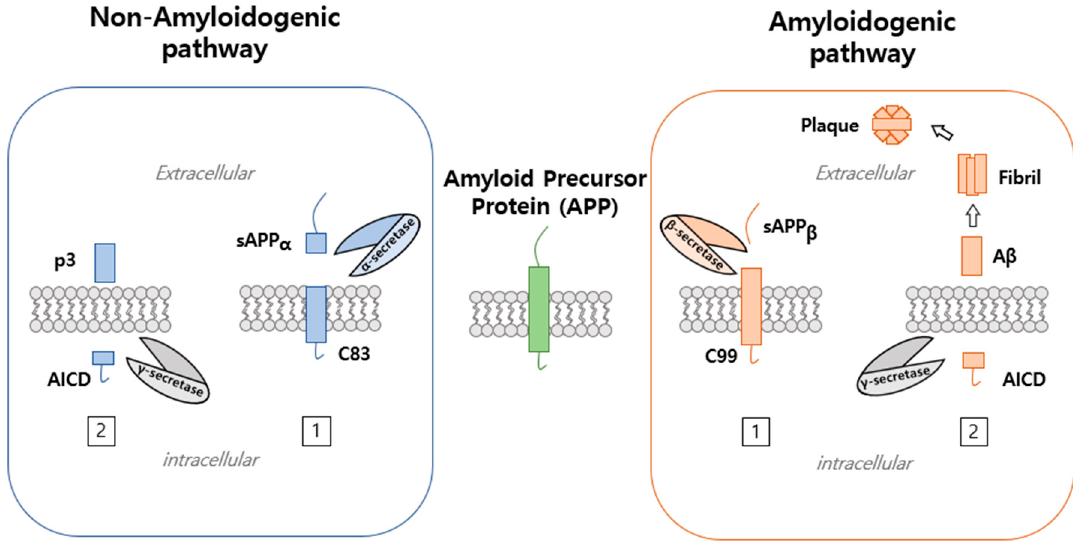
Figure 2. Processing pathway of amyloid precursor protein. APP processing is performed via the non-amyloidogenic or amyloidogenic pathways. The non-amyloidogenic pathway involves APP cleavage by α -secretase and generates soluble amyloid precursor protein cleaved by α -secretase (sAPP α ) and a C-terminal fragment of 83 (C83). This is followed by γ -secretase cleavage, which results in APP non-amyloidogenic extracellular fragment (p3) and APP intracellular domain (AICD). On the other hand, the amyloidogenic pathway involves APP cleaved by β -secretase to generate soluble amyloid precursor protein, which is further cleaved by β -secretase (sAPP β ) to generate a C-terminal fragment of 99 (C99) that is cleaved by γ -secretase to generate amyloid-beta (A β ).